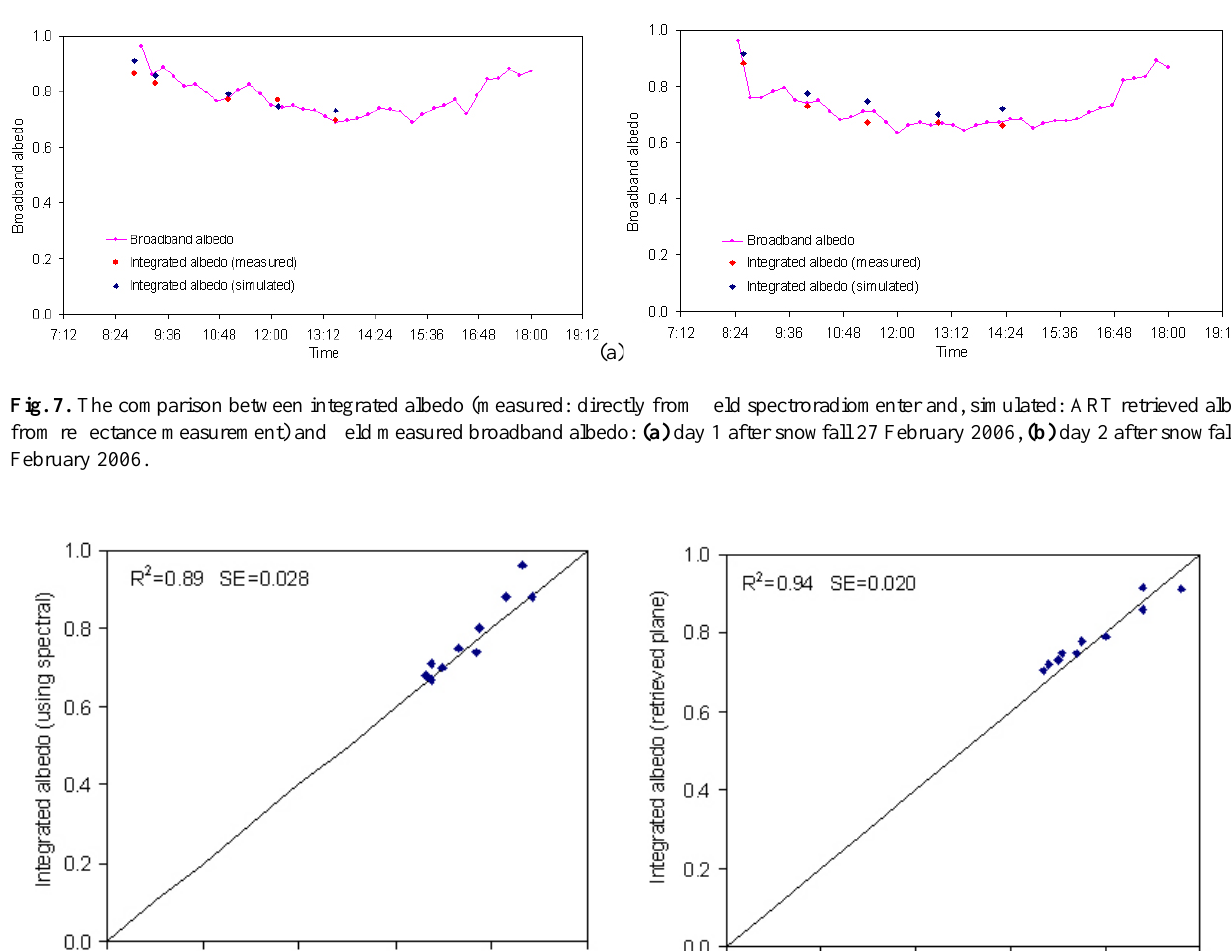
www.the-cryosphere.net/5/203/2011/ The Cryosphere, 5, 203–217,